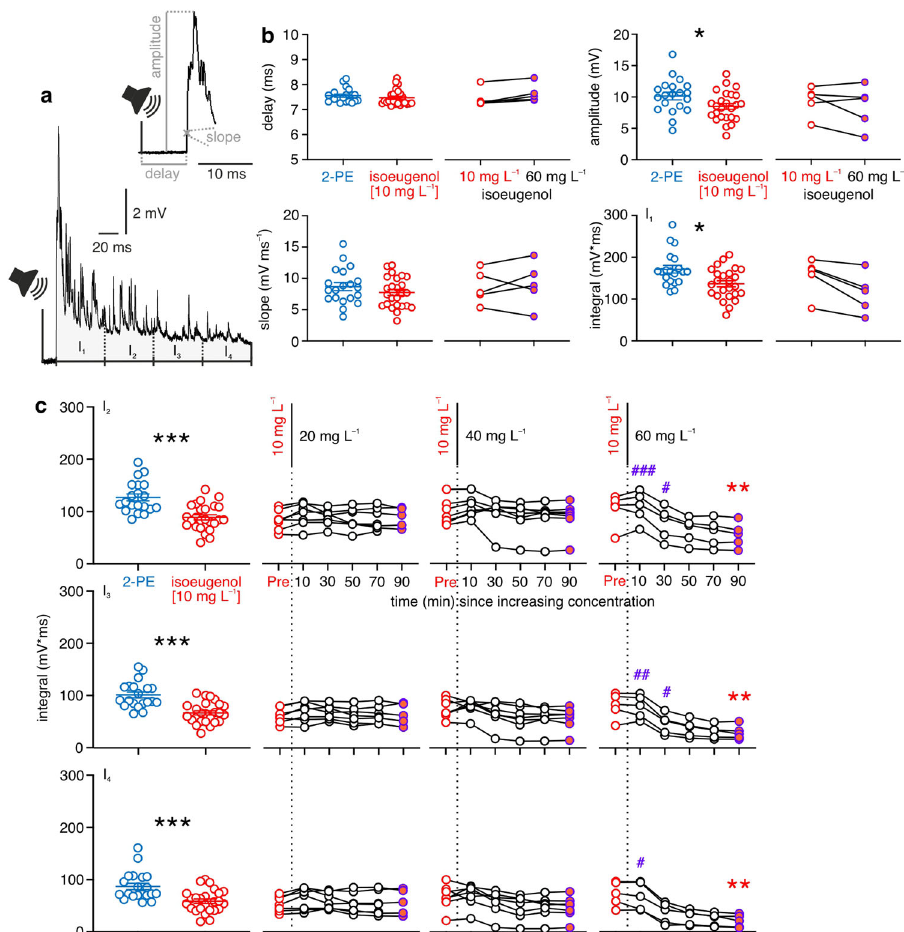
Fig. 3 Isoeugenol slightly affects acoustic inputs into the Mauthner neuron. a Exemplary PSP recorded after acoustic stimulation of the fi sh, with indication of measurements taken. b Acoustic PSPs were slightly reduced in peak amplitude and in I 1 in fi sh anesthetized with isoeugenol [10 mg L − 1 ] ( n = 25; red circles for individual fi sh), compared to the 2-PE controls ( n = 20; blue circles). Means ± standard errors of mean are indicated. Slope and delay were not affected. This remained so at isoeugenol concentrations up to 60 mg L − 1 (for time course see Supplementary Fig. 2). Changes of values obtained at 10 mg L − 1 and 90 min after increasing dose in the n = 5 experimental fi sh, in which the concentration was increased from 10 to 60 mg L − 1 , indicated on the right for each individual fi sh. c Detailed analysis of integrals I 2 to I 4 , arranged as in Fig. 2 with time indicating exposure time passed since switch (dotted vertical line at time = 0 min) to higher concentration. Signi fi cant differences between values obtained before the increase in isoeugenol concentration (Pre; red circles) and values obtained 90 min after the increase in concentration (orange fi lled circles) are indicated in ( c ) by red asterisks. Signi fi cant differences between values obtained 90 min after dose increase (orange fi lled circles) and values determined also after dose increase but earlier (black outlined circles) are indicated by violet hashtags. One, two, and three symbols indicate P ≤ 0.05, P ≤ 0.01, or P ≤ 0.001, respectively. Same fi sh as in Fig. 2. Connected circles indicate mean values of individual fi